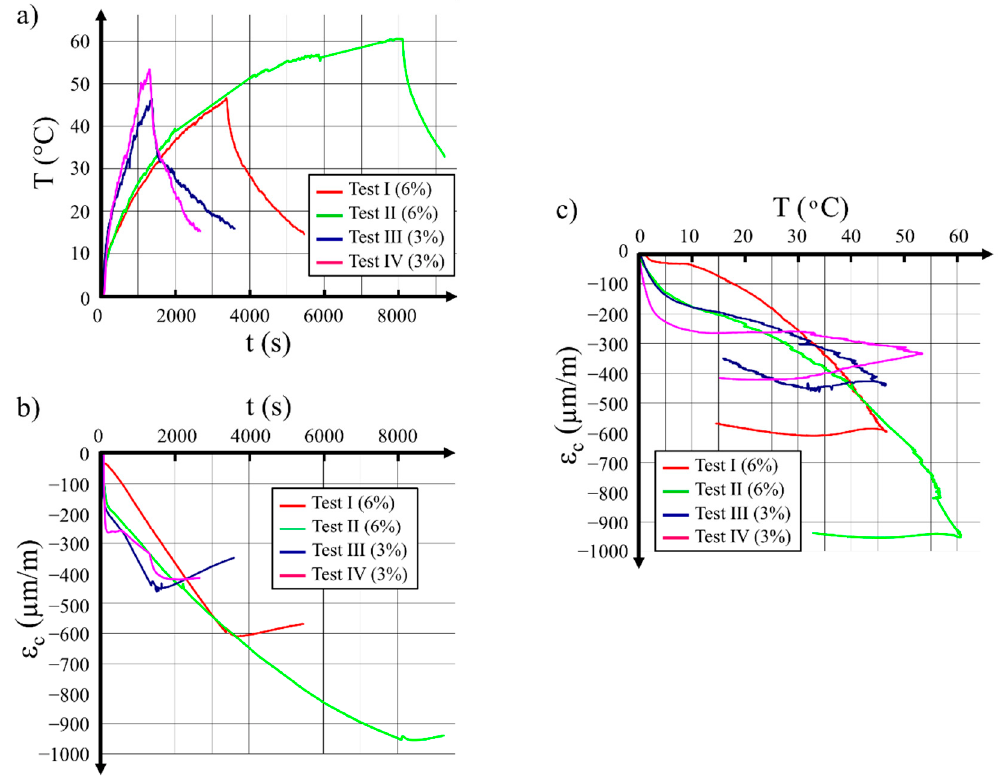
Figure 5. Results captured during tests with Ni–Ti wire with a diameter of 2 mm wound on the 250 mm diameter pipe: ( a ) wire temperature variations over time during electric heating, then cooling; ( b ) variations of circumferential concrete strain over time; ( c ) variations of circumferential concrete strain as a function of temperature. Note that measurements for test II were stopped before the specimen was cooled to the ambient temperature.